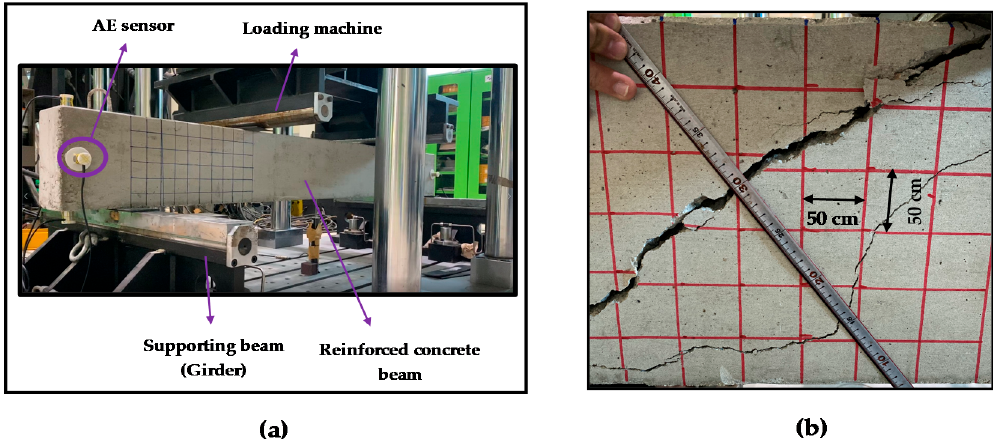
Figure 3. Actual experimental set-up of the three-point bending test for concrete beam: ( a ) whole setup and ( b ) measuring scale used to measure the cracks.